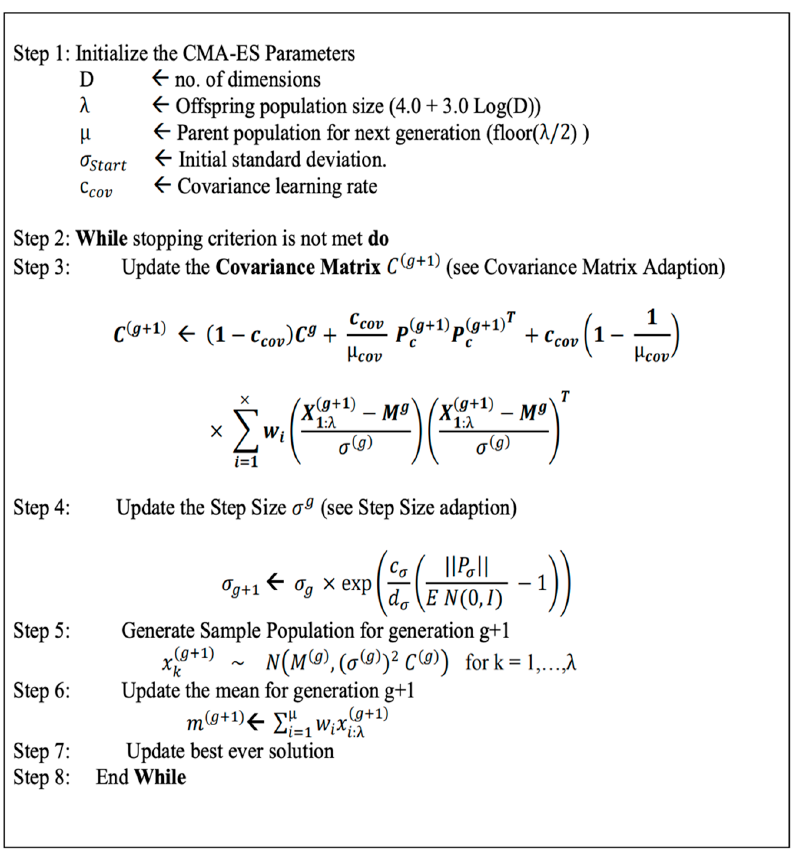
Figure 2. The pseudo-code of the CMA-ES algorithm [23].